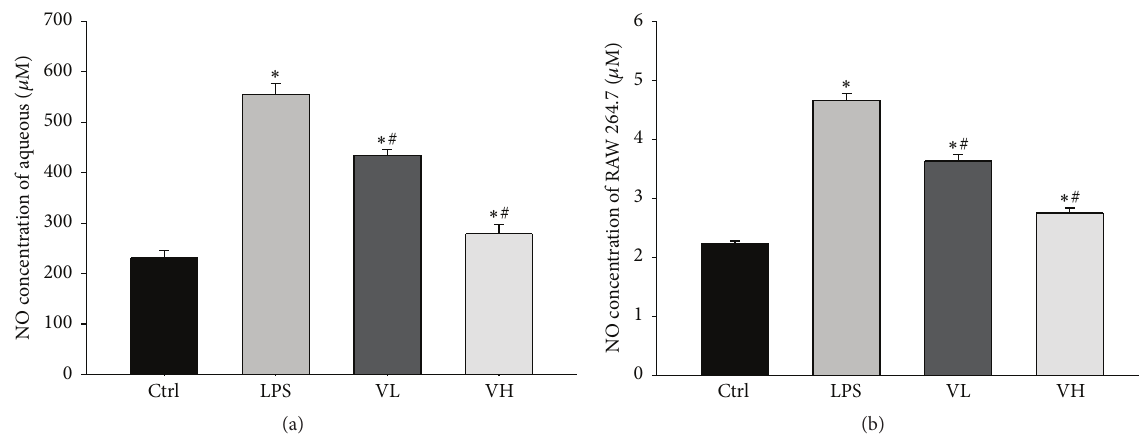
Figure 8: The concentrations of NO in the aqueous humor as measured by ELISA. The concentrations of NO in the aqueous humor of EIU rats (a) and in RAW 264.7 cells treated with LPS (b). The aqueous humor was isolated under control conditions (Ctrl), pretreatment with LPS (LPS), and pretreatment with low-dose bortezomib (VL) or high-dose bortezomib (VH). LPS injection increased the NO production in the aqueous humor of EIU rats, and treatment with bortezomib significantly decreased the NO concentration in the aqueous humor in a dose-dependent manner. The symbols “ ∗ ” and “#” indicate statistical significance.